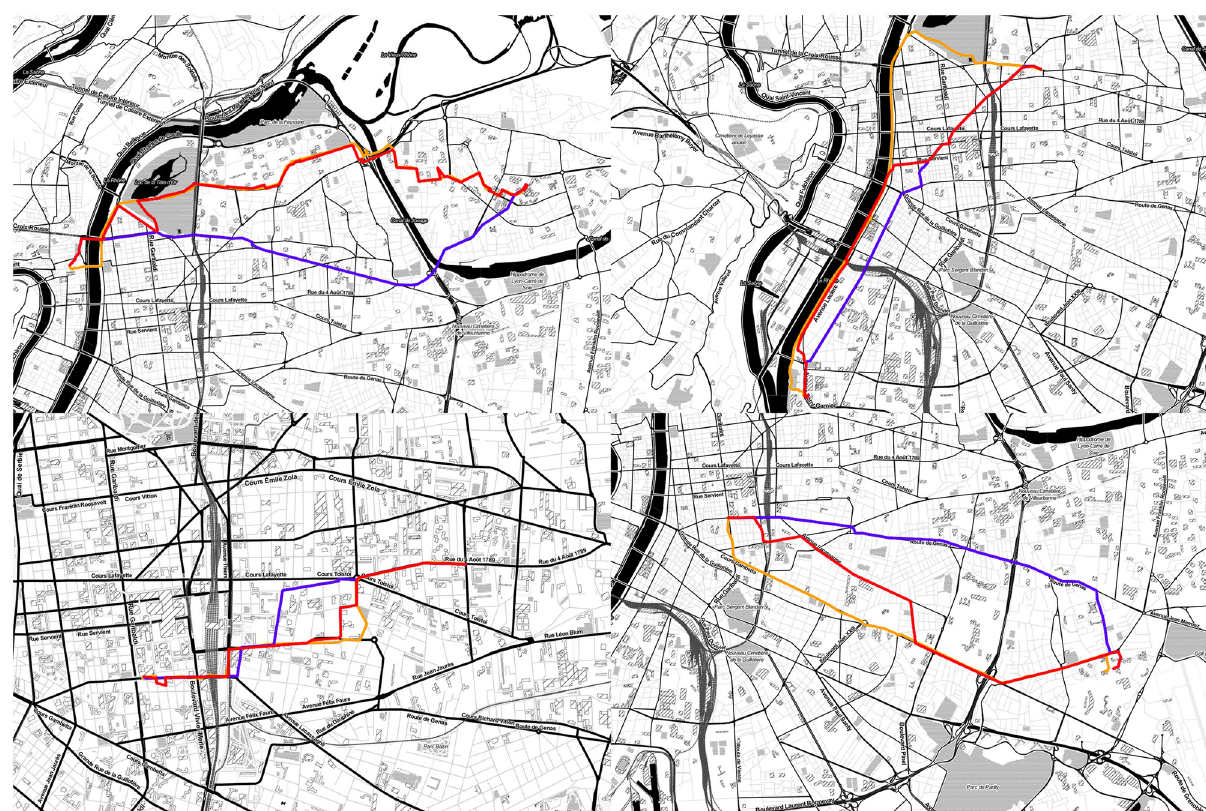
Fig 12. Maps showing four experienced tracks (orange lines), the corresponding computed tracks (blue lines) and the experience-based tracks created with our model (red lines) between the experienced tracks’ O/D pairs.